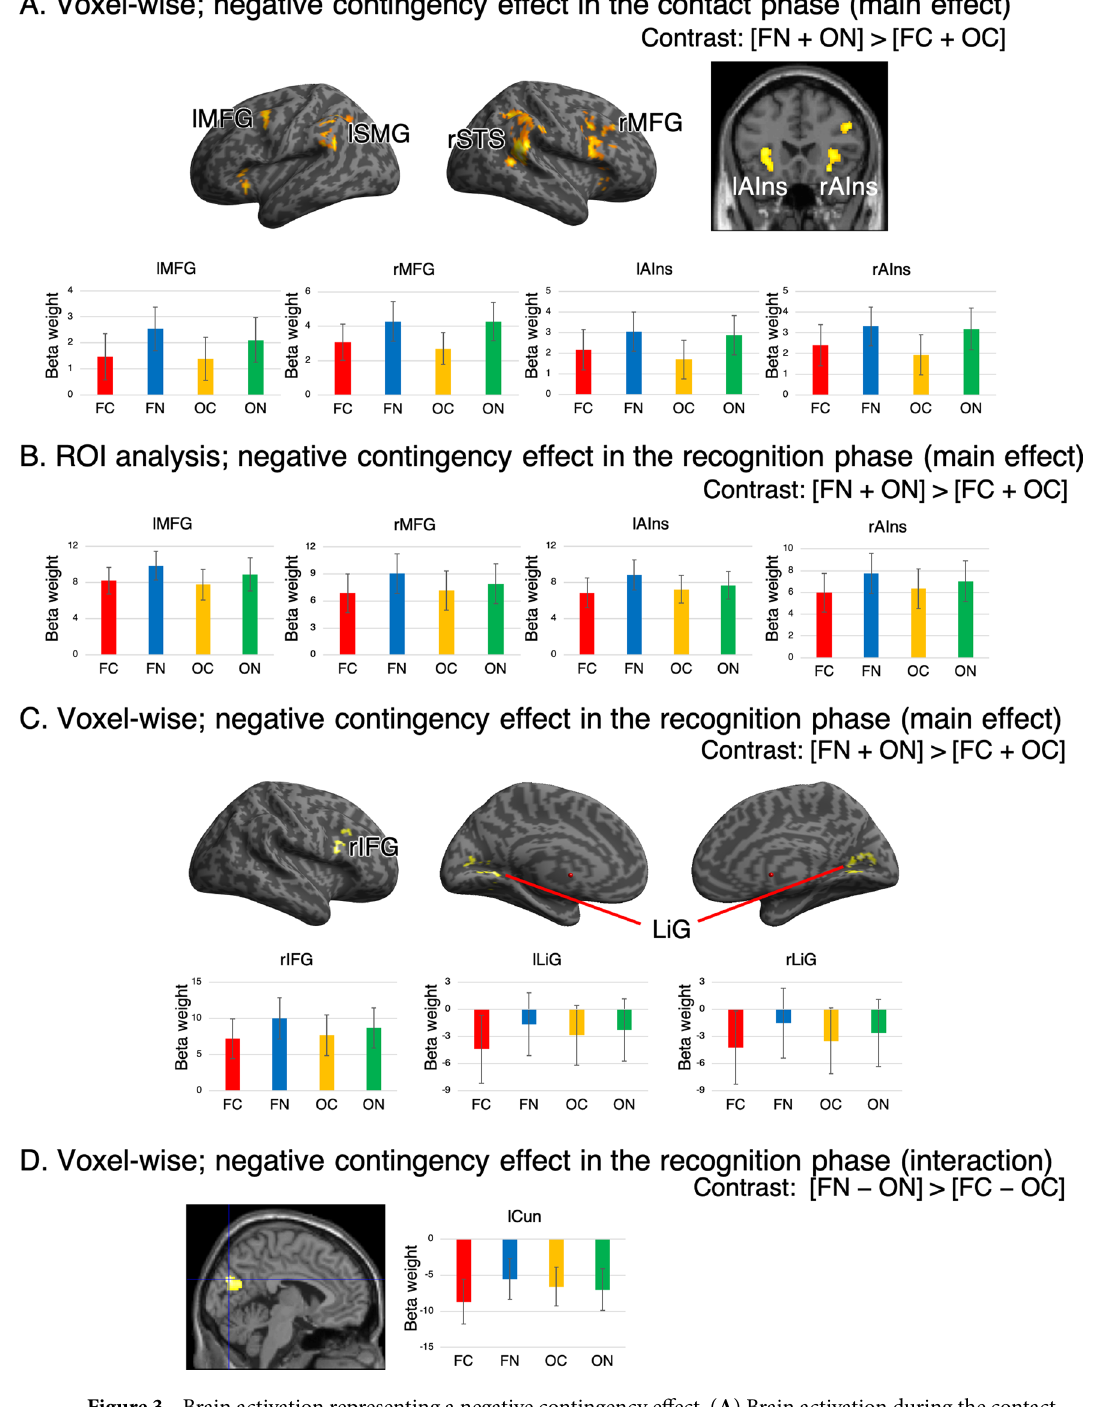
Figure 3. Brain activation representing a negative contingency effect. ( A ) Brain activation during the contact phase representing a negative contingency effect according to voxel-wise analysis. The threshold was set according to an uncorrected P- value < 0.001 and corrected P- value < 0.05 based on cluster size. The graphs are activation profiles (beta weights) for the middle frontal gyrus and bilateral anterior insula, which were significantly activated in both voxel-wise and region of interest (ROI) analyses. Error bars represent 95% CIs. ( B ) Activation profiles of brain regions in the bilateral middle frontal gyri and bilateral anterior insula during the recognition phase. Error bars represent 95% CIs. ( C ) Brain activation during the recognition phase according to voxel-wise analysis, derived from the main effect of the negative contingency effect contrast. ( D ) Brain activation during the contact phase, derived from the contrast representing the negative contingency effect of the interaction between contingency and face perception (i.e., [FN − ON] > [FC − OC]). lSMG = left supramarginal gyrus; rSTS = right superior temporal sulcus; rIFG = right inferior frontal gyrus; LiG = lingual